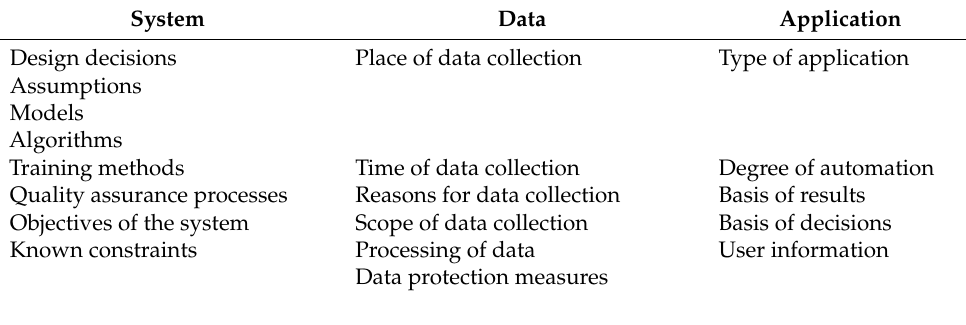
Table 3. List of possible information to be communicated to different